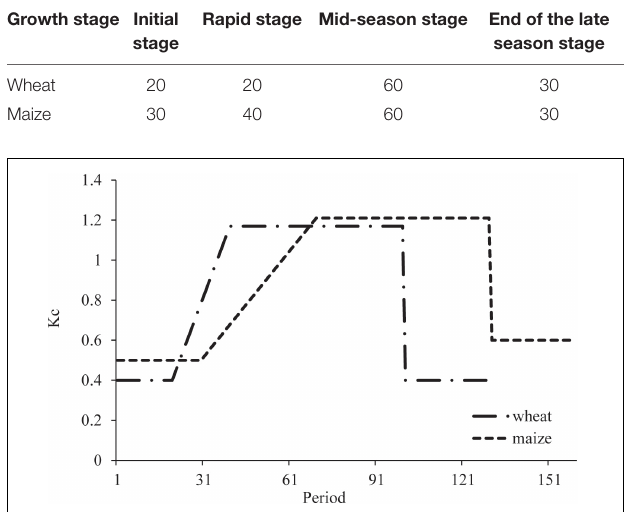
TABLE 1 | Growth stages length of wheat and maize in Zhangye (unit: days).